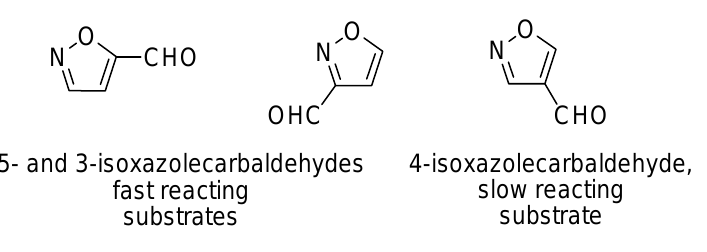
Figure 3. Isoxazolecarbaldehydes used in MBH